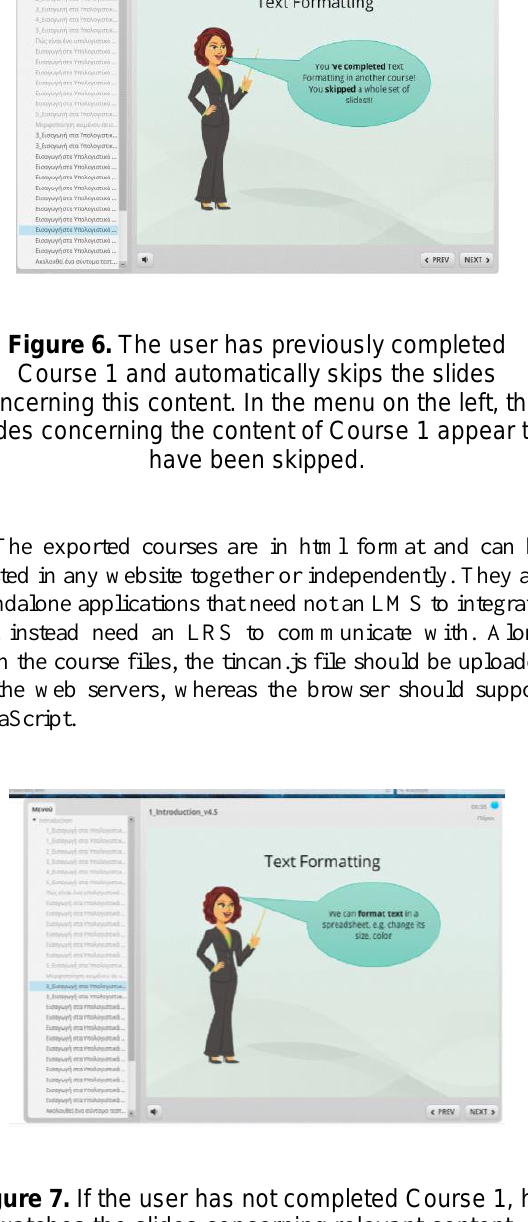
Figure 9. The ADL LRS interface for